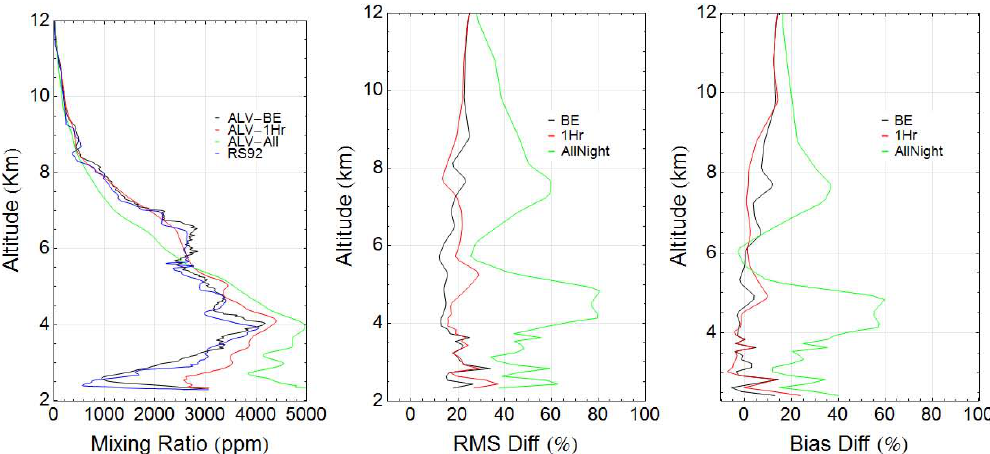
Fig. A7. Left panel: comparison of best estimate, 1h sum and “all-night” ALVICE profiles and the RS92 radiosonde launch on 25 October at 03:55UT. Mean RMS (middle panel) and bias (right panel) of the different ALVICE data products compared with all 33 RS92 radiosonde launches. The RMS and bias are calculated from the individual lidar-radiosonde comparisons with 100m vertical binning up to 6km and 400m binning above 6km.